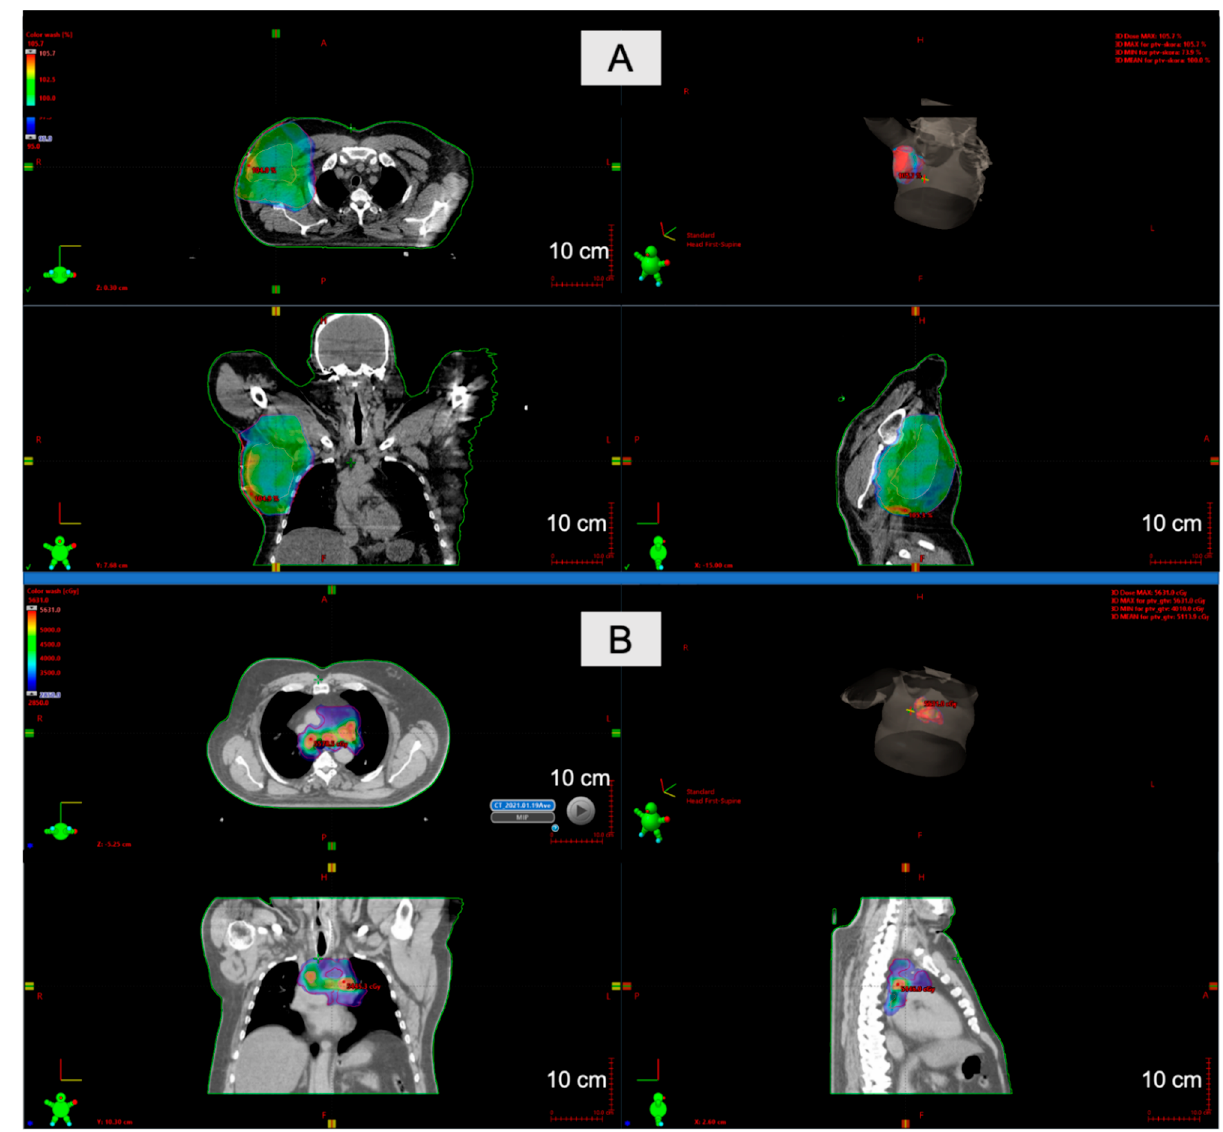
Figure 5. Radiotherapy for eccrine porocarcinoma. The patient received adjuvant radiotherapy ( A ) after axillary lymph node dissection due to locally advanced porocarcinoma with five lymph node metastases with extracapsular extension using intensity-modulated radiotherapy, 60 Gy in 2 Gy fractions. After six months of follow-up, the patient developed lung metastases, and he underwent chemotherapy followed by pulmonary metastasectomy. The first computed tomography after surgery showed mediastinal lymph nodes metastases. Then, the patient received hypofractionated radiotherapy ( B ) for oligometastatic disease using volumetric modulated arc therapy with simultaneous integrated boost, 45 and 30 Gy in 4.5 and 3 Gy fractions.